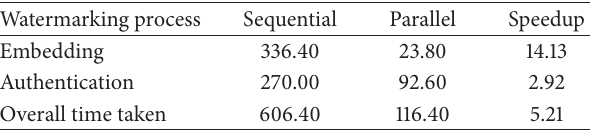
Figure 11: Sequential versus parallel watermarking authentication process in elapsed time.